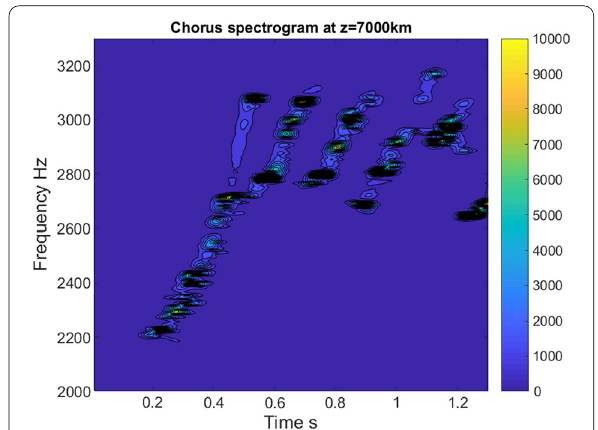
Fig. 1 Spectrogram of the exit wavefield at z simulation of narrow band chorus, triggered by a strong riser, which in turn is triggered by a weak hiss